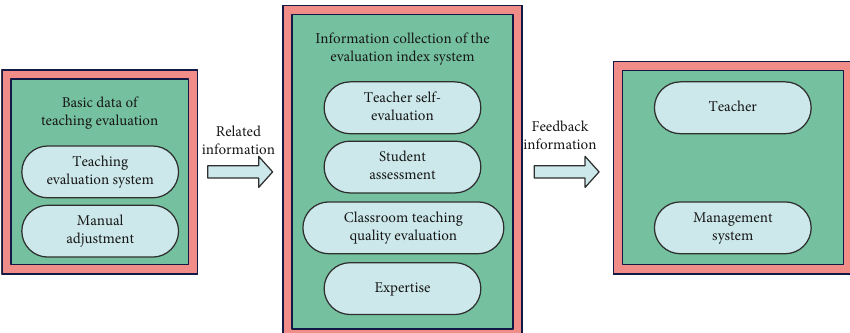
Figure 8: The overall structure design of the English teaching process evaluation system based on the Rasch